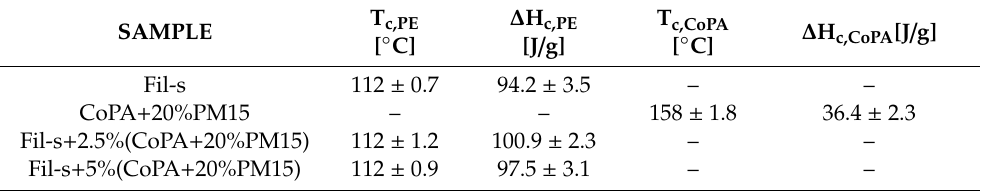
Table 6. Thermal data relative to the cooling scan (where T c,PE , ∆ H c,PE and T c,CoPA , ∆ H c,CoPA are the crystallization temperatures and enthalpies of the PE and CoPA phases, respectively) for Fil-s, CoPA + 20%PM15 masterbatch, and their blends.